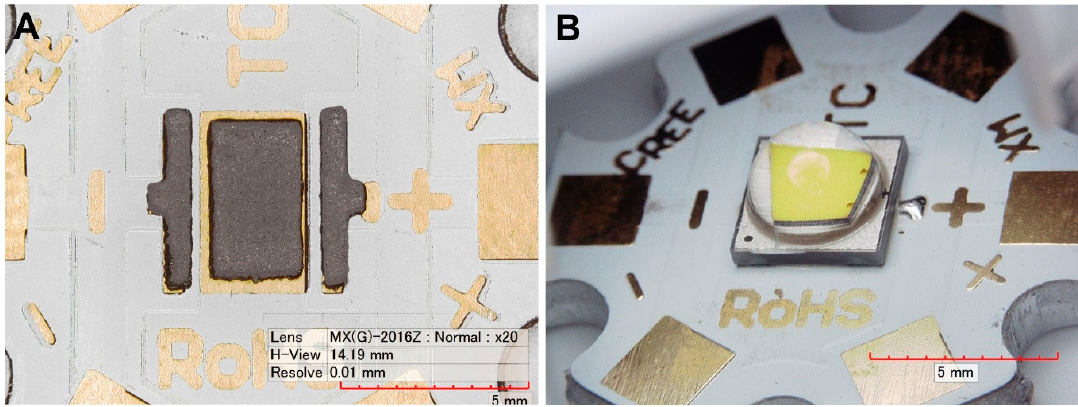
Figure 1. The sample circuit: ( A ) solder paste (SACX0307-nanoTiO 2 ) coverage of the thermal pad; ( B ) assembled circuit.